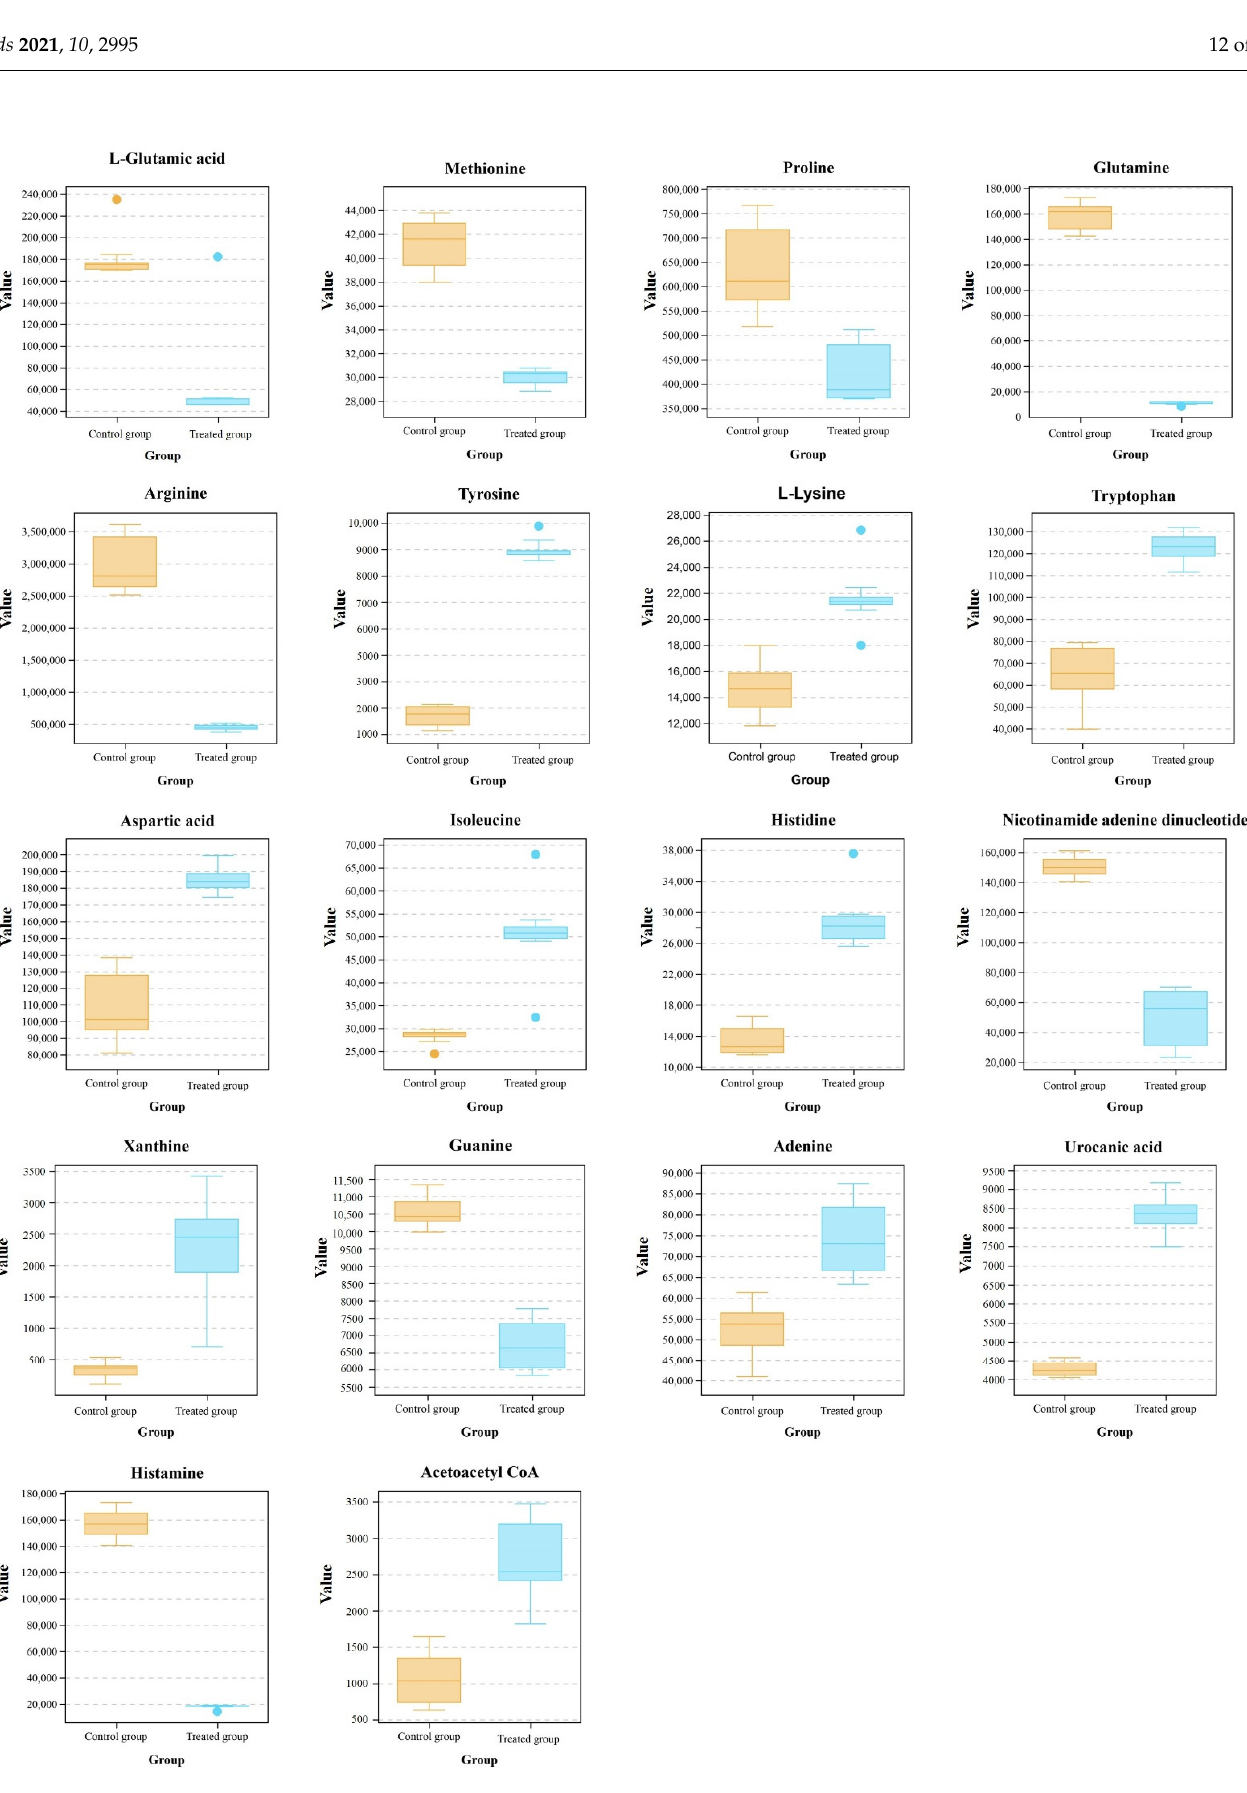
Figure 7. The boxplots of amino acid metabolism, purine, and pyrimidine metabolism in S. aureus .